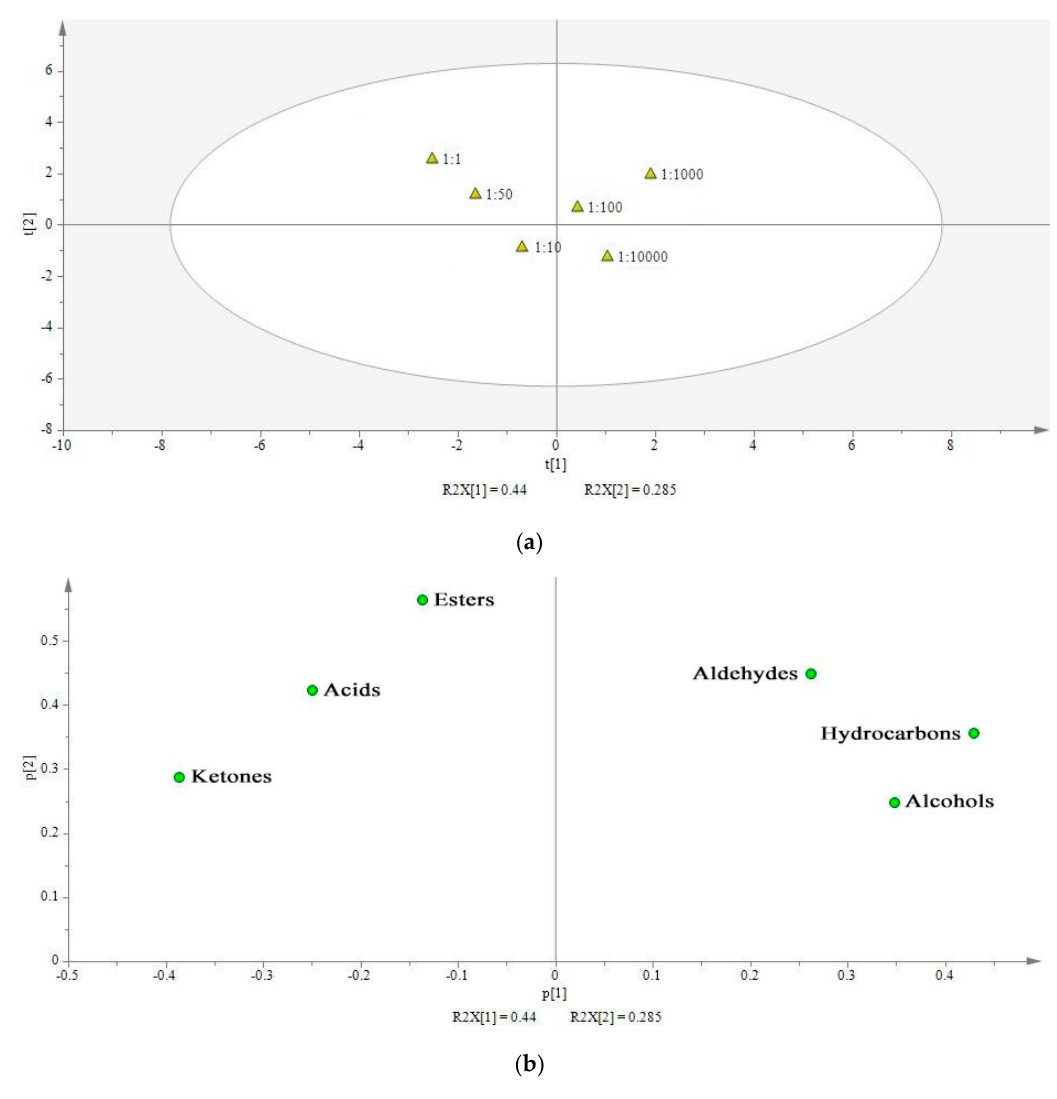
Figure 3. Principal component analysis (PCA) analysis: ( a ) Score scatter plot of six groups of samples with different strain ratios; ( b ) Loading scatter plot of six classes of volatile components.